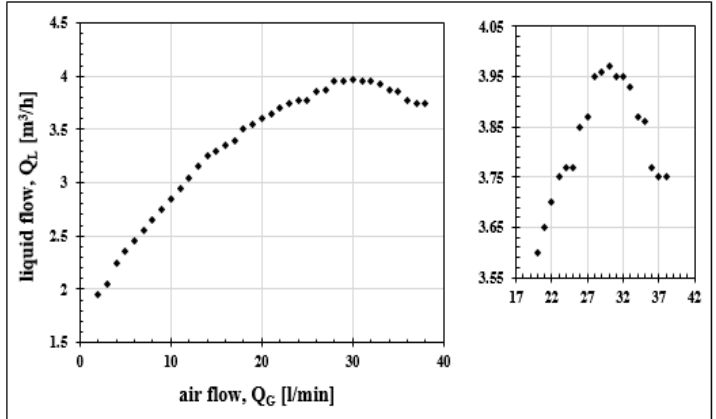
Figure 5. Evolution of the liquid flow as a function of the air flow.